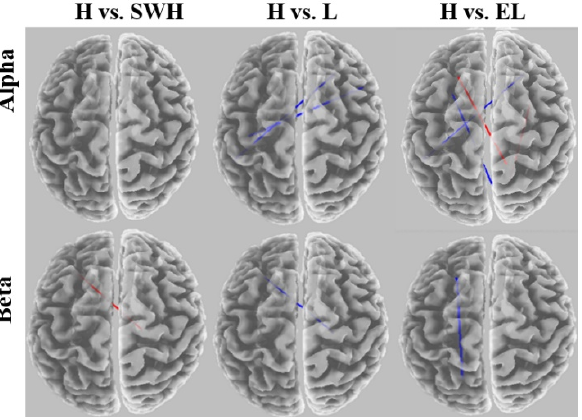
Figure 10. eLORETA wire diagram comparing hard exertion with other exertion levels for each frequency band. EL: extremely light, L: light, SWH: somewhat hard, and H: hard.